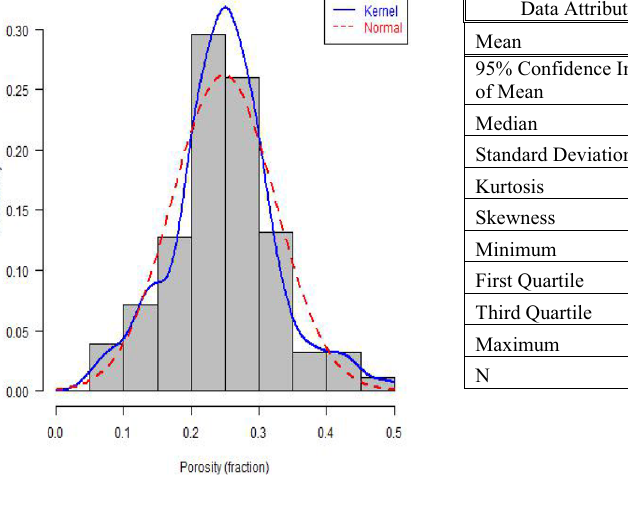
Fig. 10 Descriptive statistics and distributions of all individ- ual porosity values—Horizon